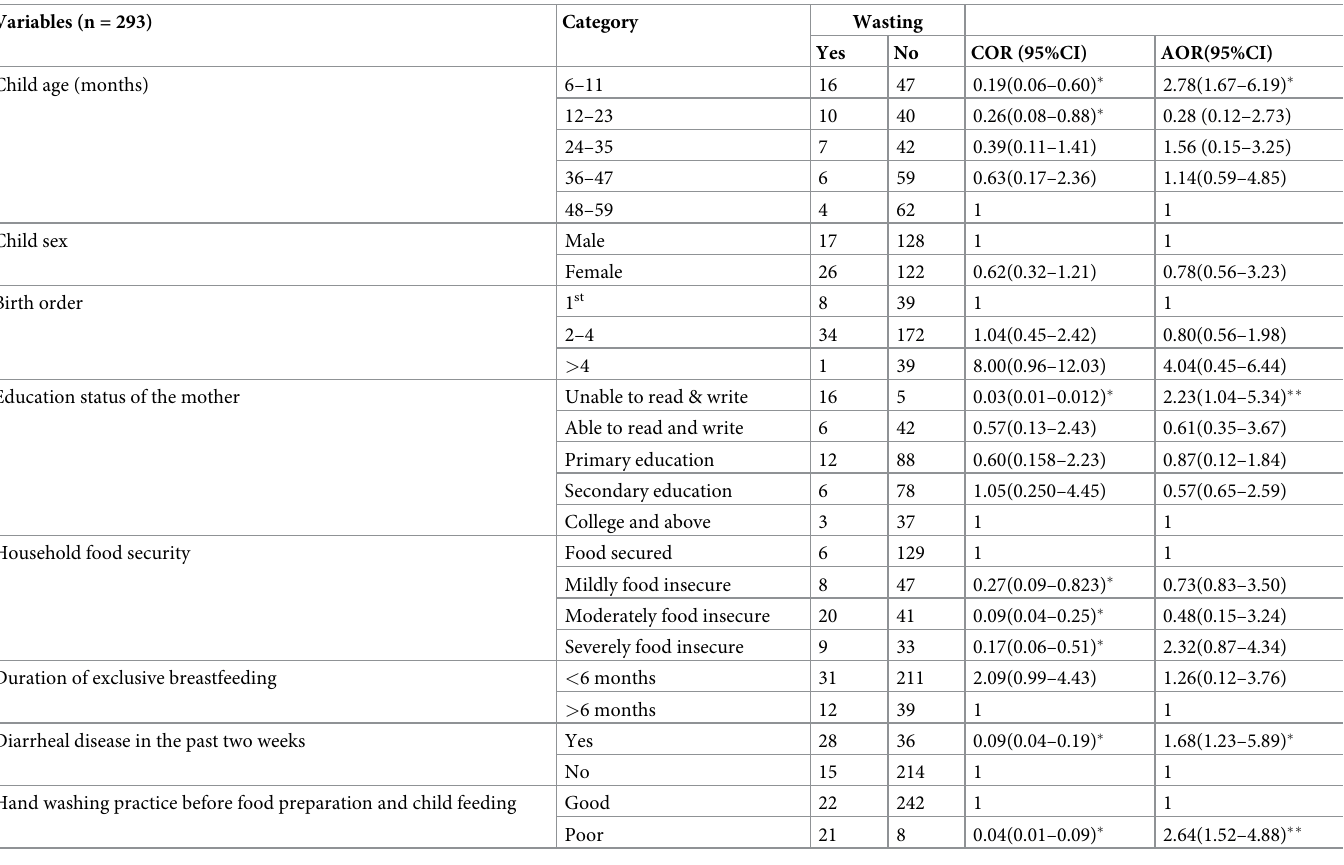
Table 4. Factors associated with child wasting in Wolkite town, Gurage zone, southern Ethiopia,